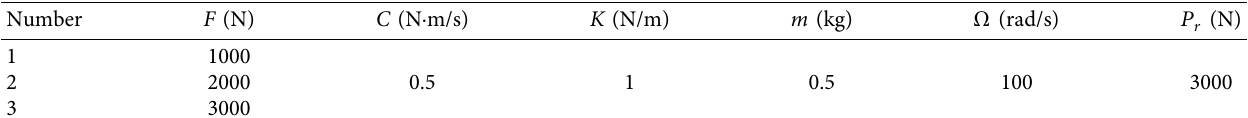
Table 4: Calculation parameters.